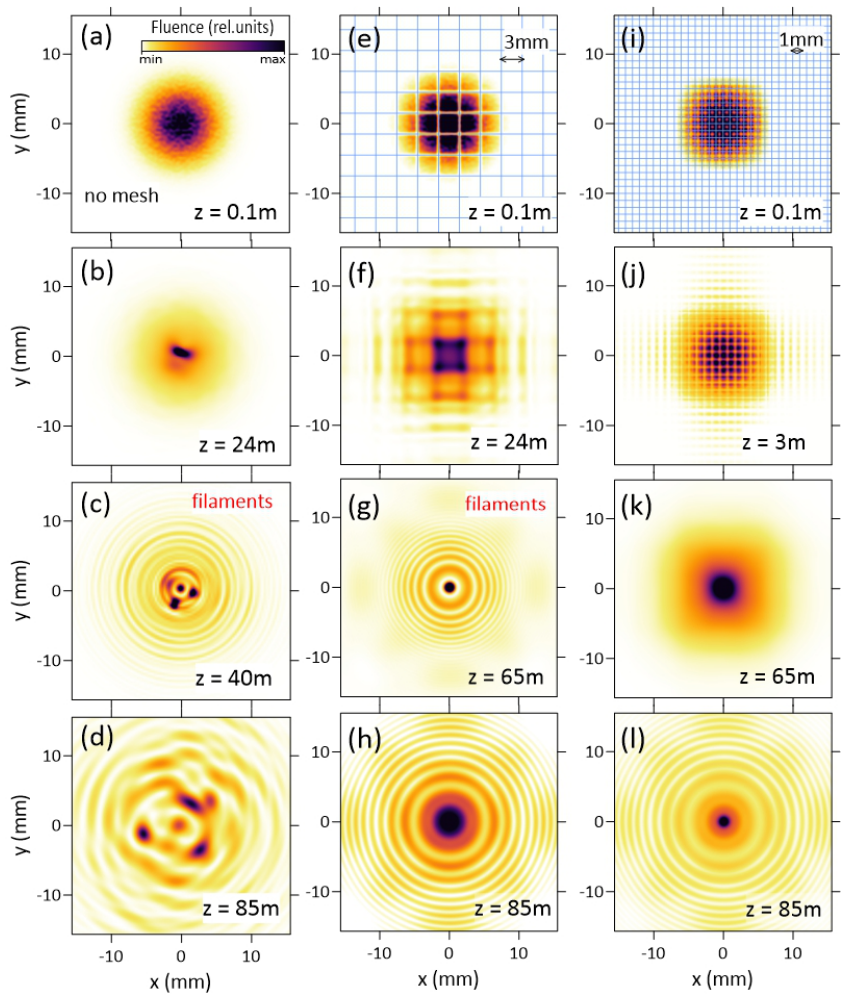
Figure 3. Transverse fluence profiles (normalized to the maximum value) at various propagation distances z without modulation (left column, ( a – d )), when modulated by meshes with 3-mm (middle column, ( e – h )) and 1-mm (right column, ( i – l )) cells. Mesh amplitude masks are shown by the blue grids at ( e , i